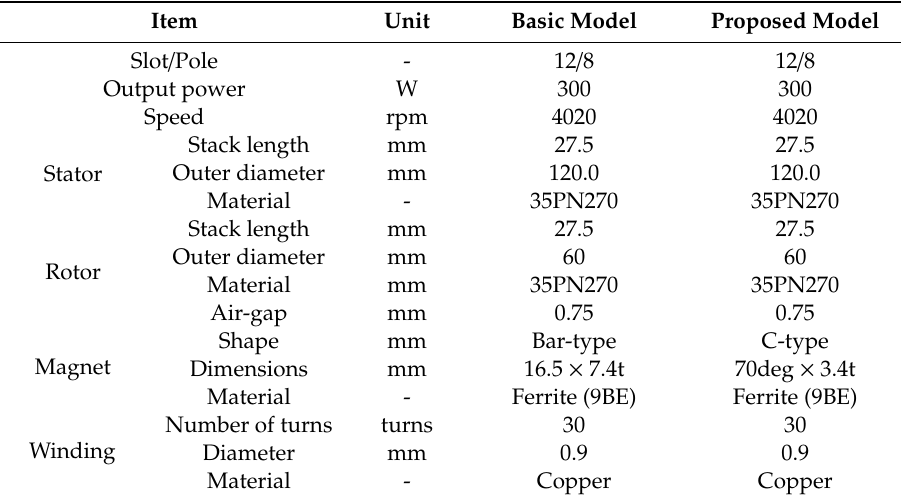
Table 1. Specifications of the basic model and proposed model.